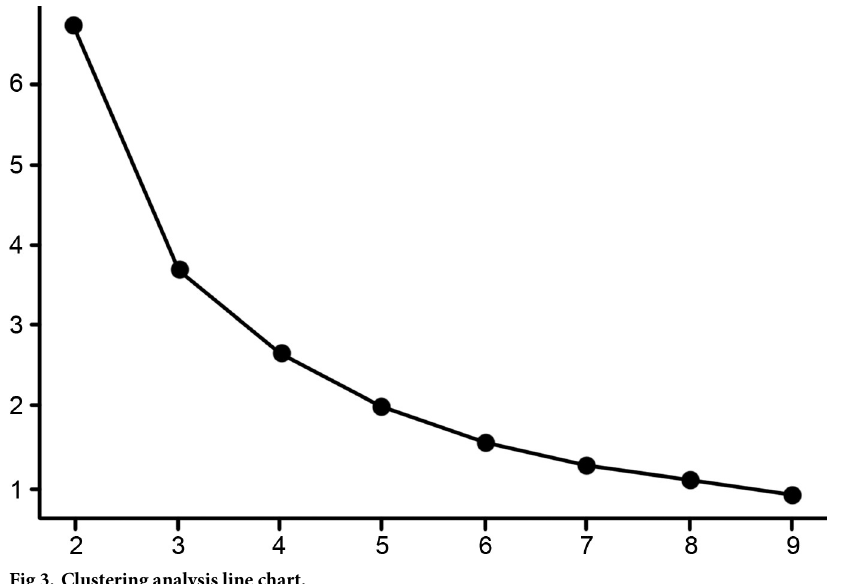
Fig 3. Clustering analysis line